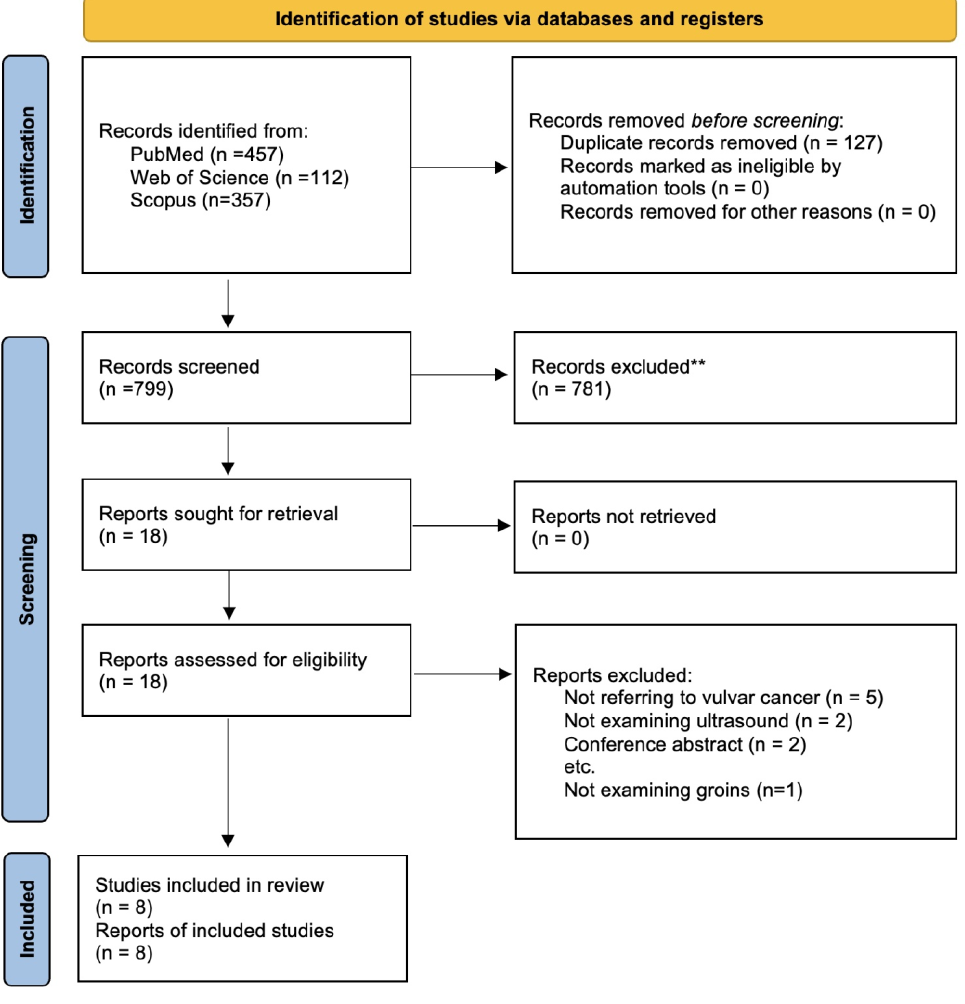
Figure 1. Flow diagram of the screening and selection process (from Page et al., 2021).